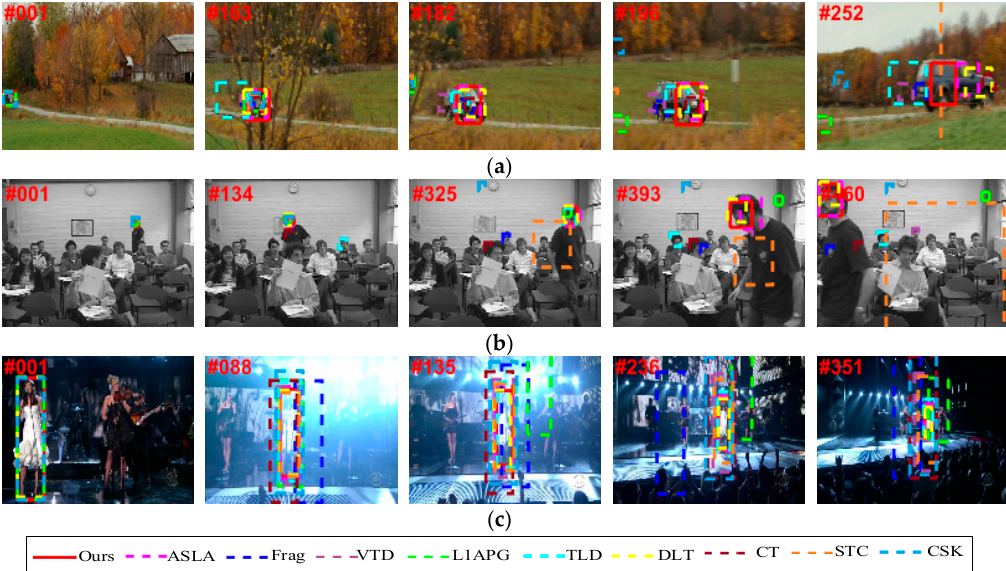
Figure 10. Screenshots of some sampled tracking results, where objects suffer from significant scale variations. ( a ) CarScale with scale variation and occlusion; ( b ) Freeman3 with scale variation and rotation; ( c ) Singer1 with scale variation and illumination variation.